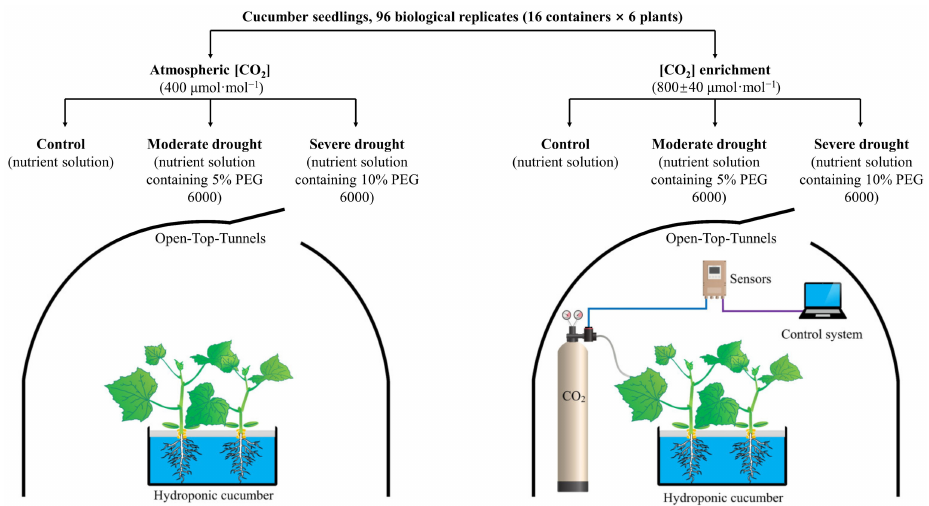
Figure 8. Schematic diagram of experimental design. Cucumber seedlings were placed in four open-top tunnels for hydroponics and two of them were treated with [CO 2 ] enrichment using gas cylinders. There were six treatments in total, with 96 biological replicates per